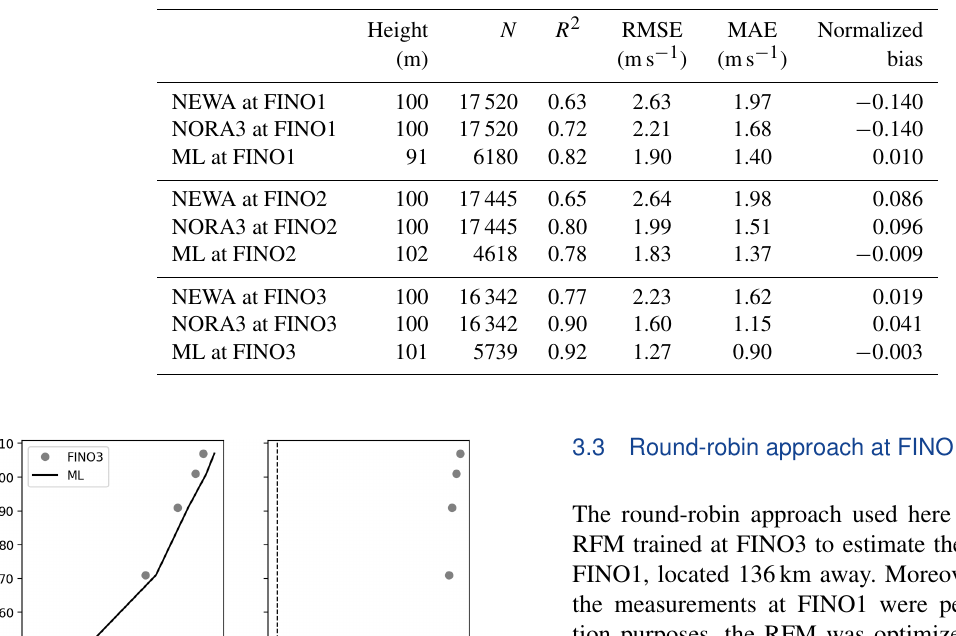
Table 5. Metrics of the NEWA WRF dataset from 2018, NORA3 data from 2018 and the random forest model (ML, machine learning) applied to the entire collocated dataset compared to the wind measurement at the height nearest to 100m at each of the FINO met masts. Random forest models were trained at each of the FINO met masts using the lowest atmospheric variable measurements available at each height. NEWA and NORA were compared with measurements at each mast at 1h averages.